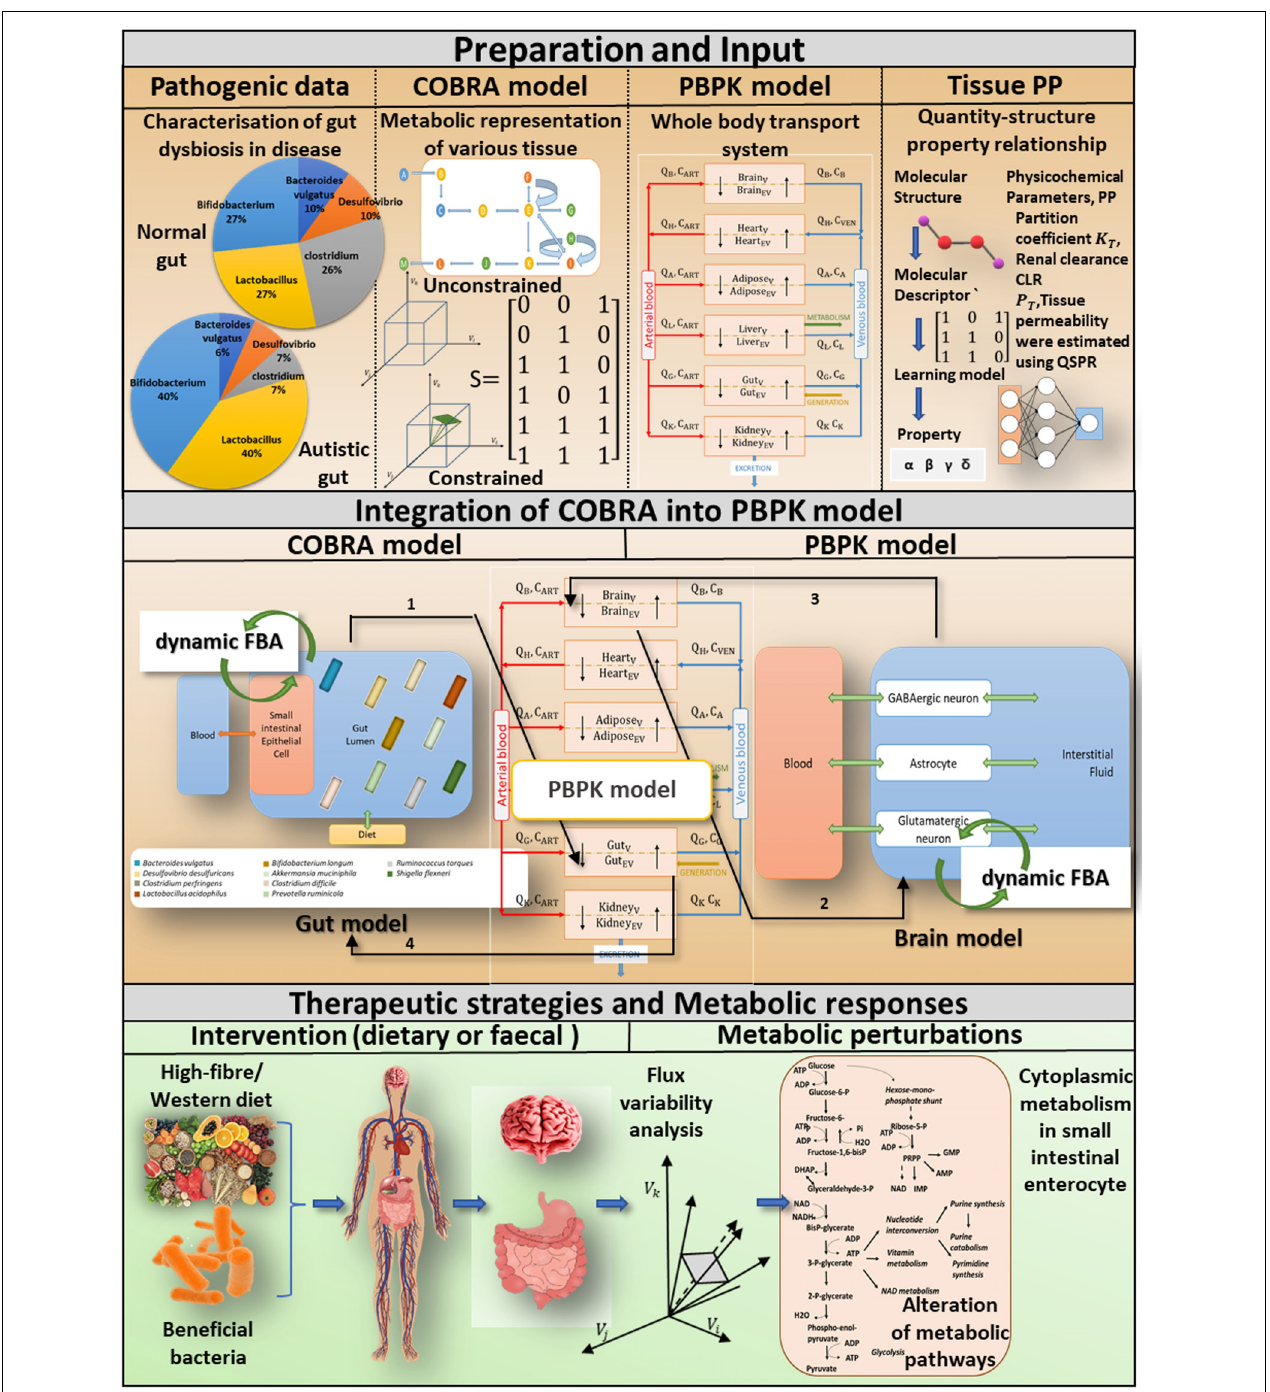
FIGURE 1 | A computational approach for incorporating tissue-specific metabolic information into a whole-body transport model to investigate pivotal role of probiotics and diet in gut dysbiosis-induced diseases. Preparations and input: We basically combine four different levels of information. COBRA is a representative gut model developed by combining patient-specific metagenomic gut dysbiosis traits with omics data from metabolic networks. A comprehensive PBPK model is integrated with the COBRA gut and brain models, and the physicochemical properties of the PBPK model are calculated using the Quantity-structure property relationship QSPR. Integration of COBRA into PBPK model: The new computational framework enables researchers to investigate the metabolic effects of ROS toxins on the host gut and brain. Tissue-specific toxin metabolism is used to quantify the production/consumption of toxins. The toxin reaction rate is constrained in the organ-specific COBRA model by the PBPK-derived toxin distribution. A static version of the dynamic Flux balance analysis algorithm (dynamic FBA) is used to calculate altered flux distributions in the drug perturbed organ-specific COBRA at a given time instant. Therapeutic strategies and metabolic responses: Toxin-induced metabolic perturbations, which result in altered intracellular and extracellular reaction rates, can be predicted using a composite representation of whole-body toxin metabolism. The integrated model explicitly considers specific dietary and probiotic interventions, as well as their impact on autistic symptoms.